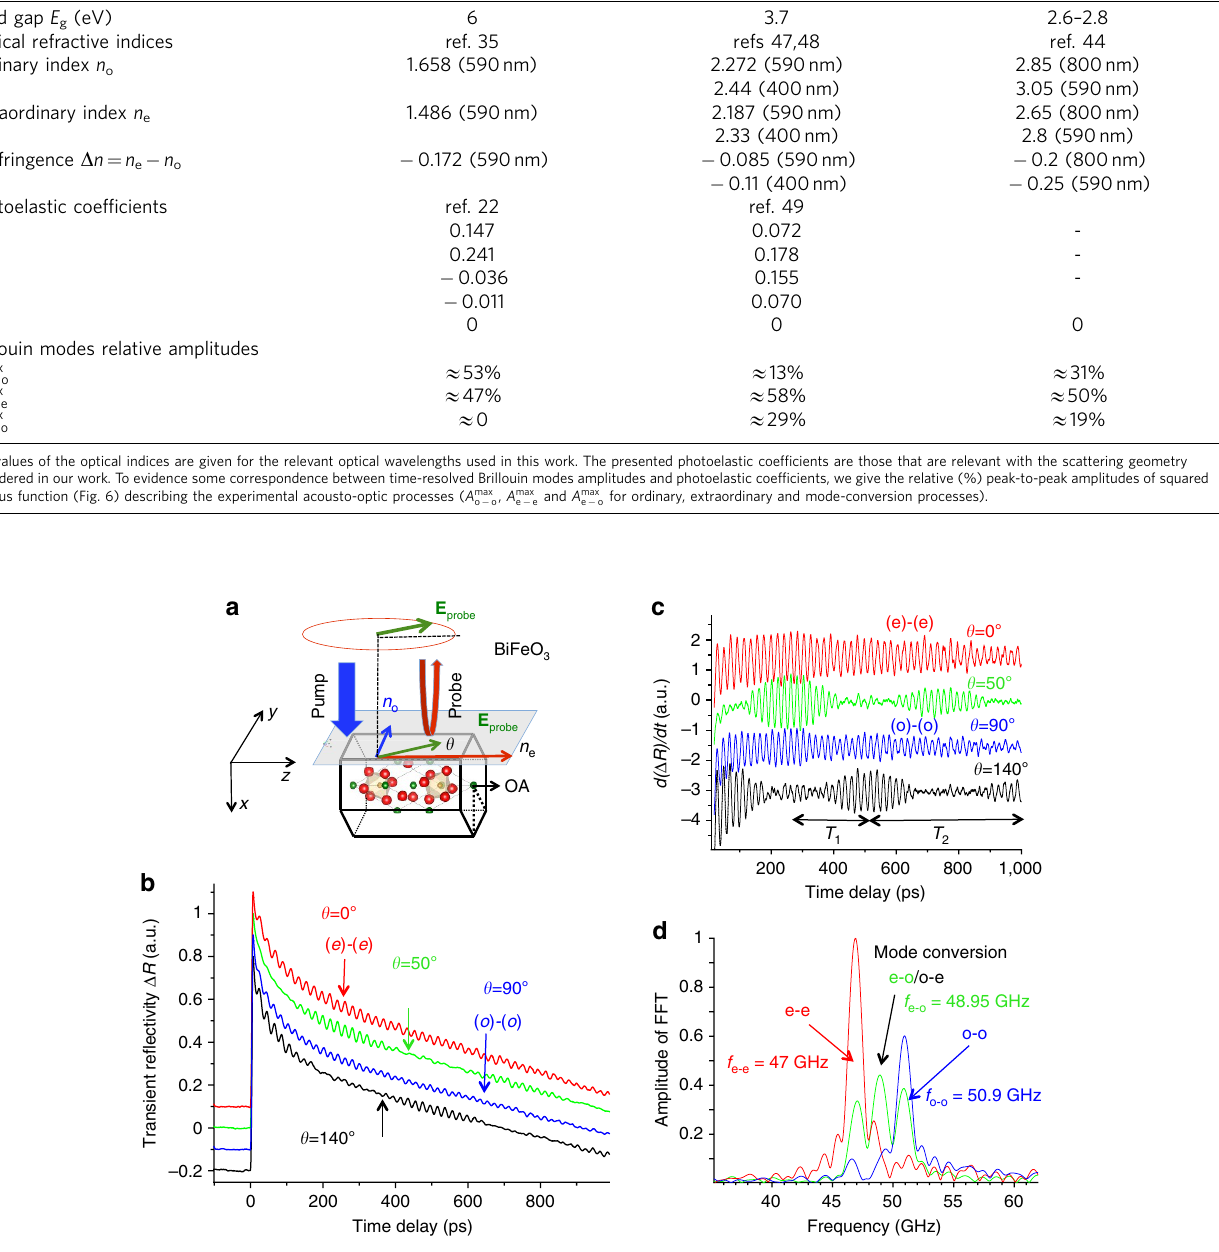
Table 1 | Optical refractive indices ( n o and n e ) and photoelastic coefficients p ij of birefringent crystals. Materials